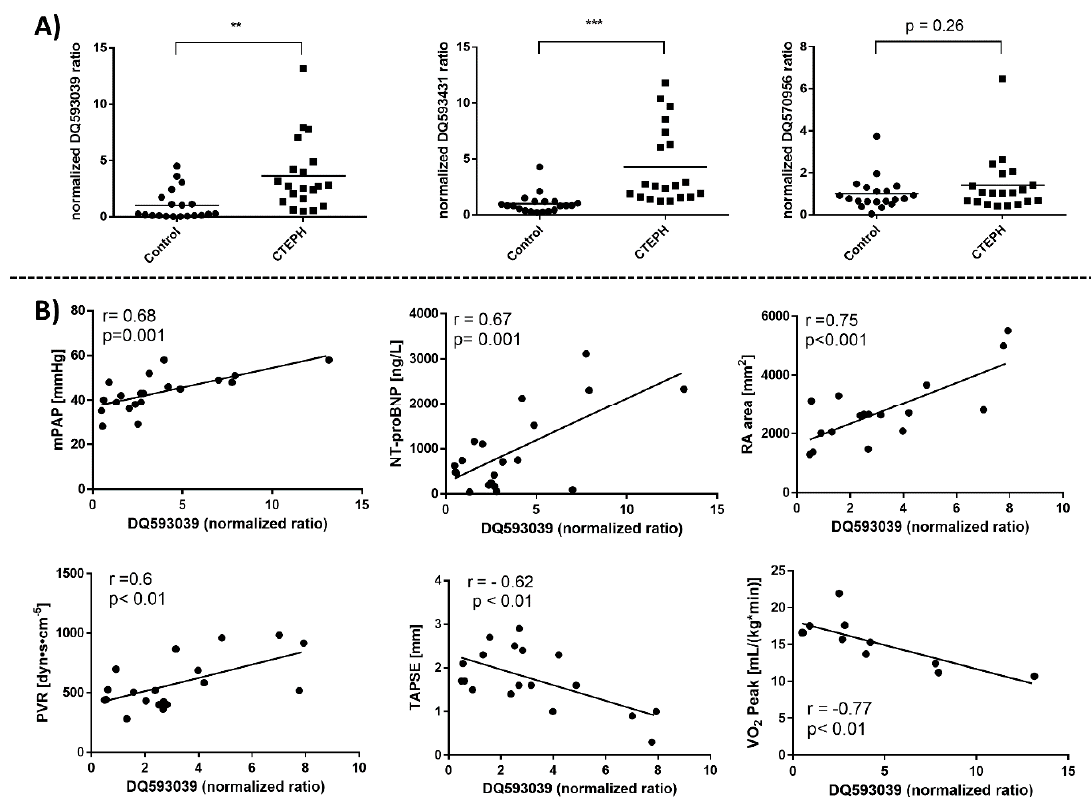
Figure 4. Differentially regulated EV-associated piRNAs in CTEPH patients vs. control individuals. EV-associated piRNAs were isolated by using the ExoEasy protocol. ( A ) qRT-PCR was performed to validate findings of the RNA sequencing. piRNA expression was standardized to the spike-in control cel-miR-39 and compared with that of controls. Lines represent mean values. Significance was determined using Student’s t -test with Welch’s correction. * p < 0.05, ** p < 0.01, *** p < 0.001; n = 20. ( B ) The clinical parameters mean pulmonary arterial pressure (mPAP), pulmonary vascular resistance, NT-proBNP levels, TAPSE, RA area, and VO 2 peak were compared with the abundance of EV- associated piRNAs in CTEPH patients by correlation analysis. Pearson correlation with 95% confidence interval is shown for normalized ratios of the EV-associated piRNA QD593039 compared with the individual clinical parameter.